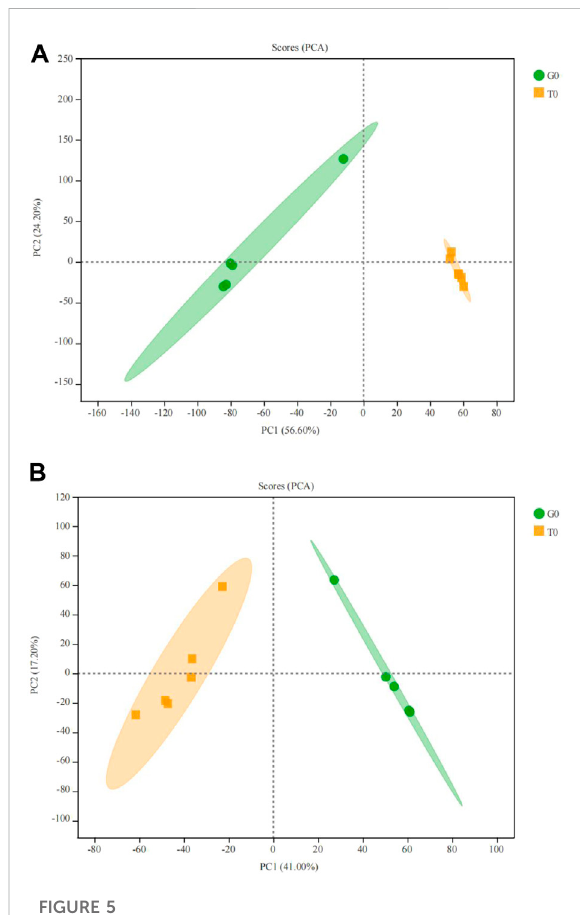
FIGURE 5 PCAscoreplotoftheserumsamplesfromthetwogroups. (A) positive ion. (B) negative